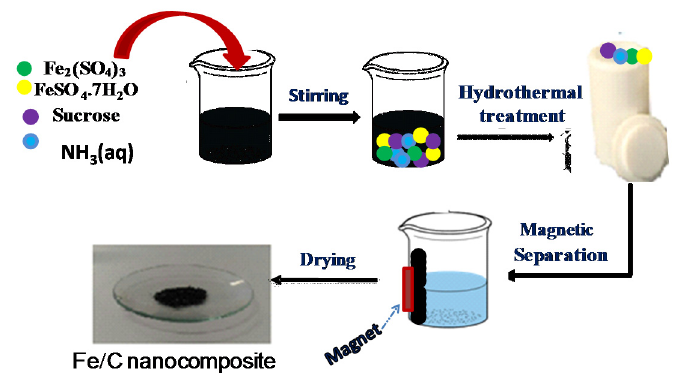
Scheme 1. Illustration of the diagram depicting the preparation of the composites.